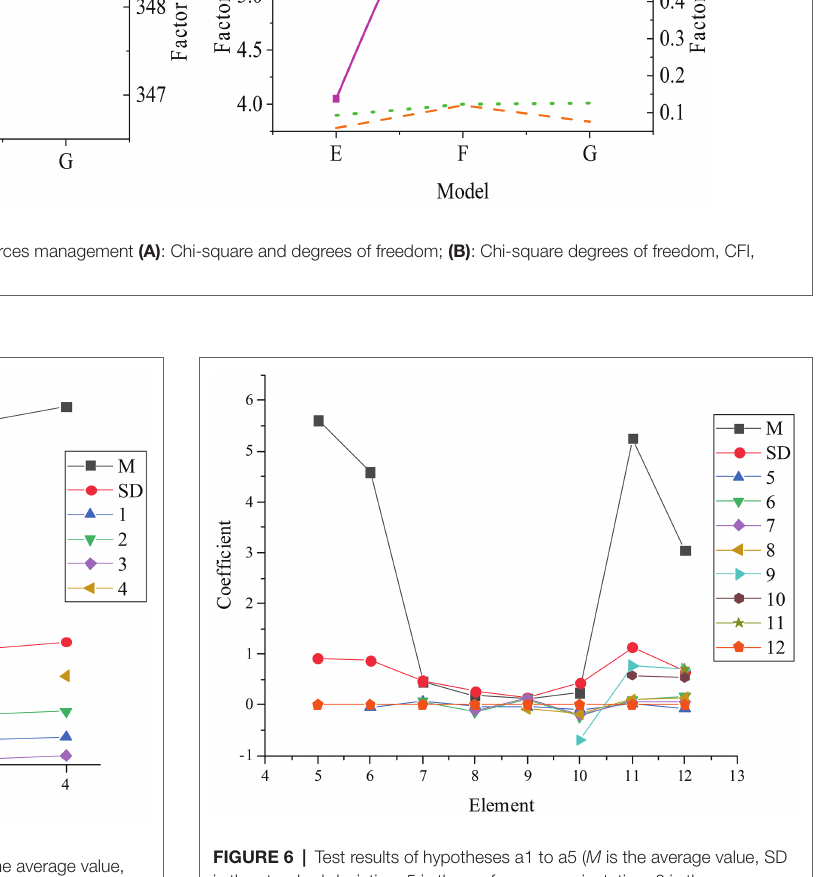
FIGURE 5 | Test results of hypotheses c1 and c2 ( M is the average value, SD is the standard deviation, 1 is the transformational leadership, 2 is the organizational psychological ownership, 3 is the advice to supervisors, and 4 is the advice to their peers).